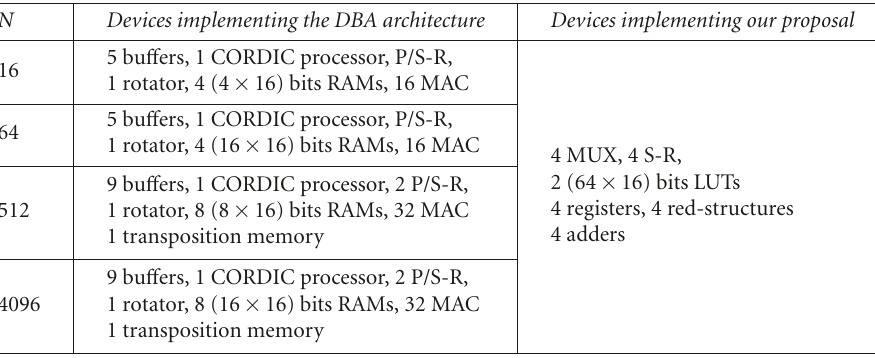
Table 9: Comparison between the hardware needed by BDA and our architecture implementations. N Devices implementing the DBA architecture